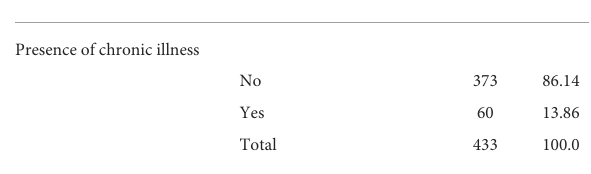
TABLE 1 Sociodemographic and economic characteristics of respondents. Variable